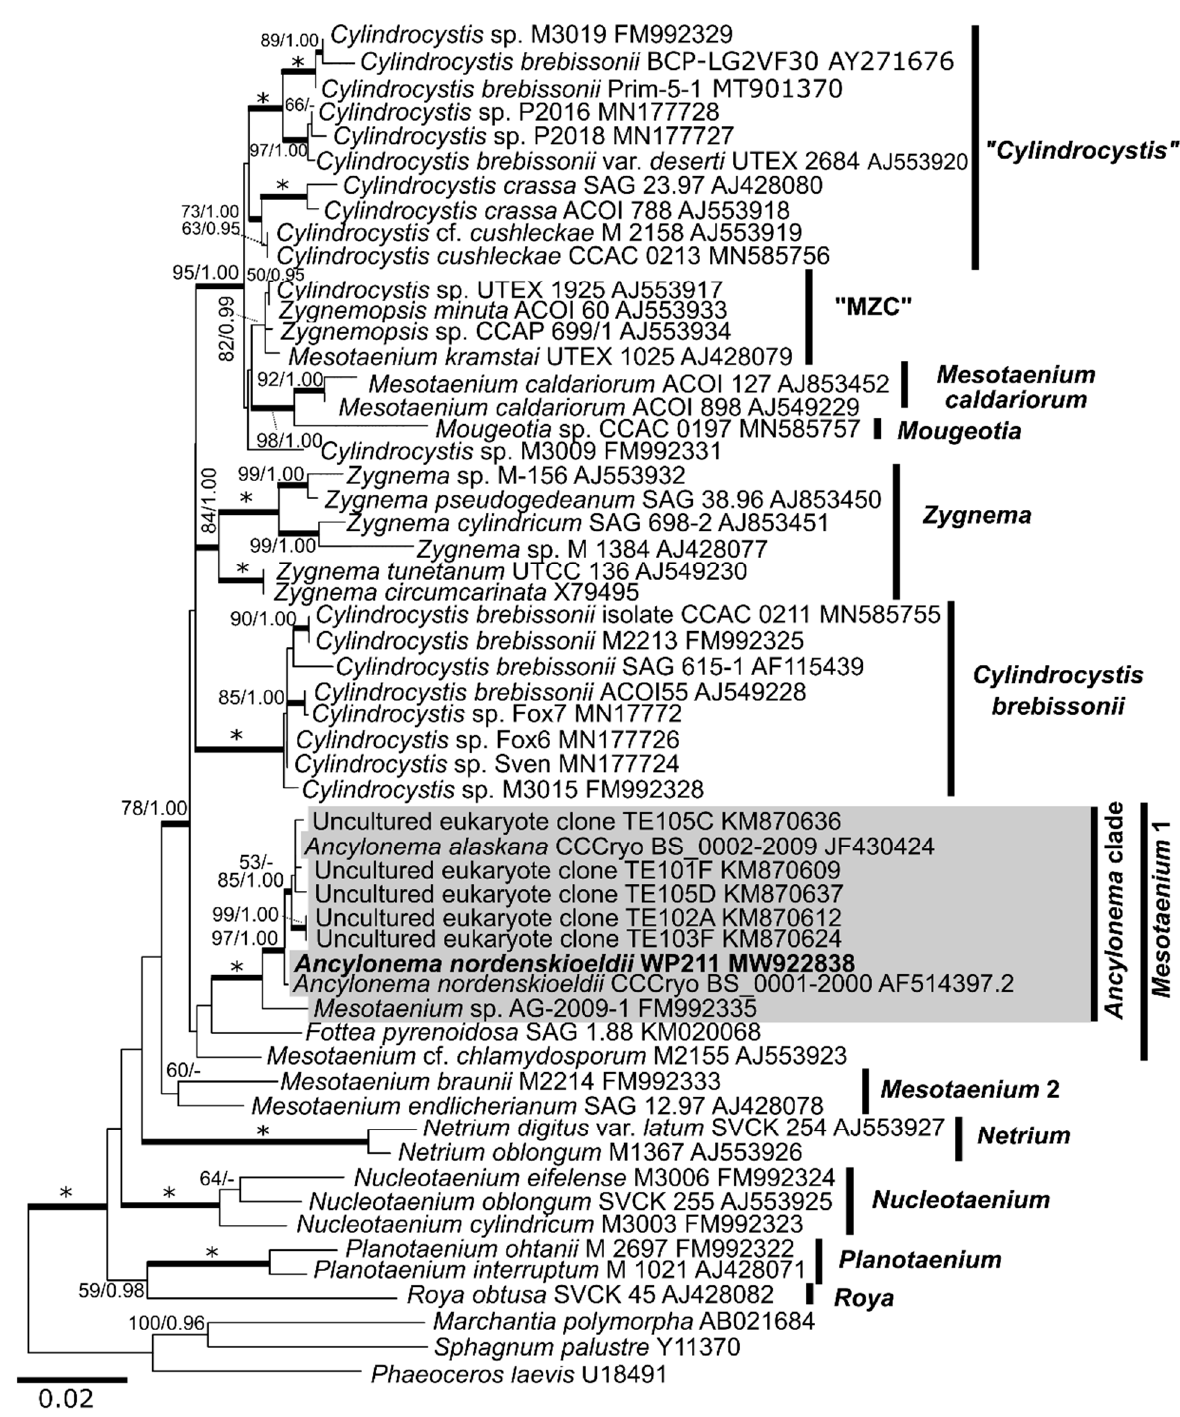
Figure 2. 18S rRNA gene-based maximum-likelihood phylogenetic tree of the Zygnematophyceae. The ‘ Ancylonema ’-clade is highlighted (grey box). All the other labelled clades correspond to [21]. Posterior probabilities ( ≥ 0.95) and bootstrap values from maximum likelihood analyses ( ≥ 50%) are shown. Full statistical support (1.00/100) is marked with an asterisk. Thick branches represent nodes receiving the highest posterior probability support (1.00). Newly obtained sequence is in bold. Accession numbers, strain or field sample codes are indicated after each species name.